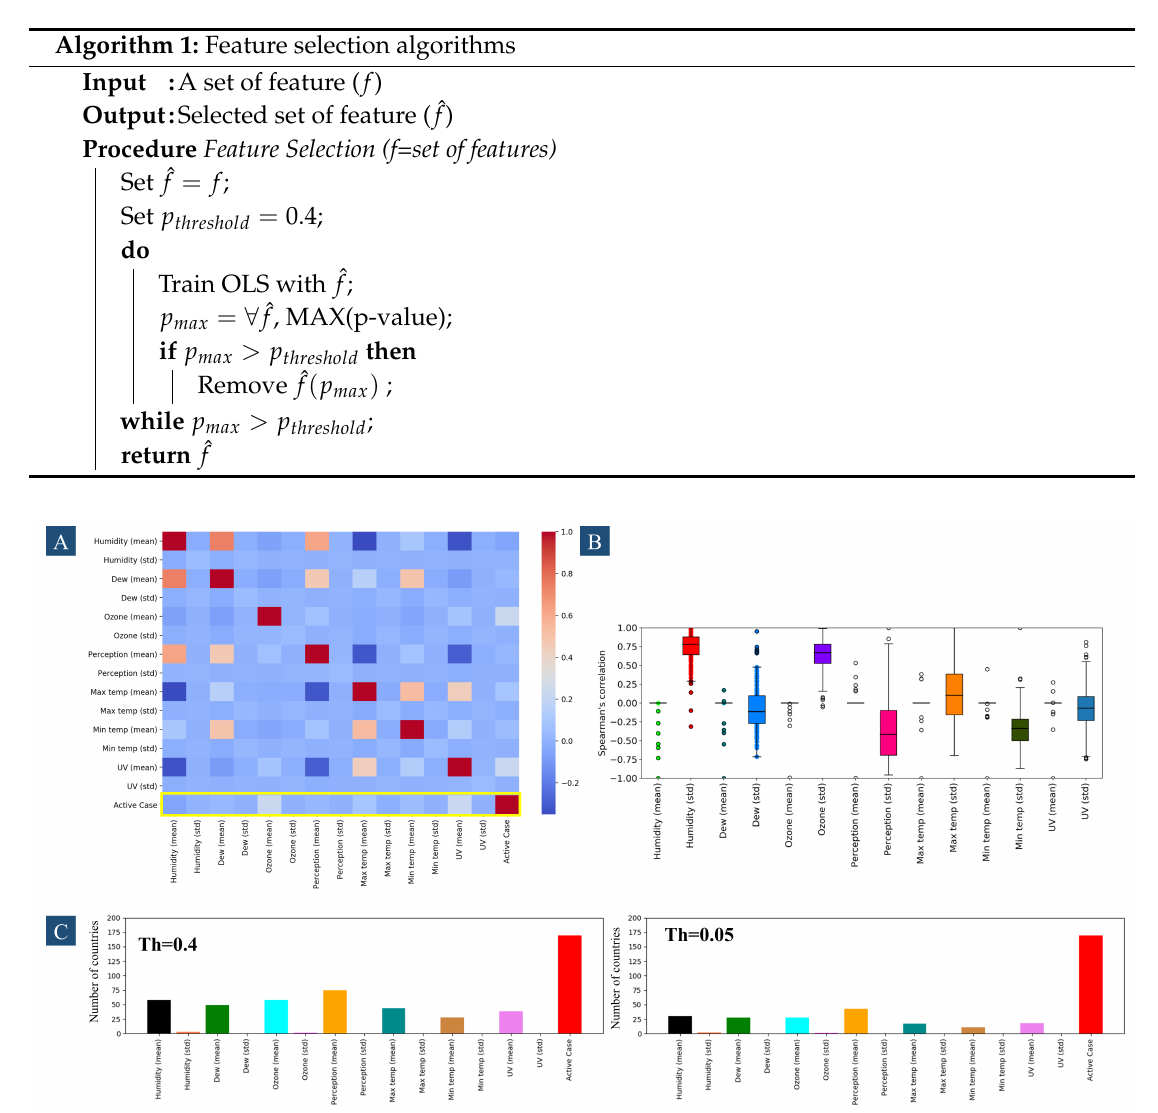
Figure 11. ( A ) Pearson correlation among features, the last row (yellow border) shows correlation with active case, ( B ) Distribution of the correlation considering all the countries, ( C ) Selected features by countries based on different thresholds.